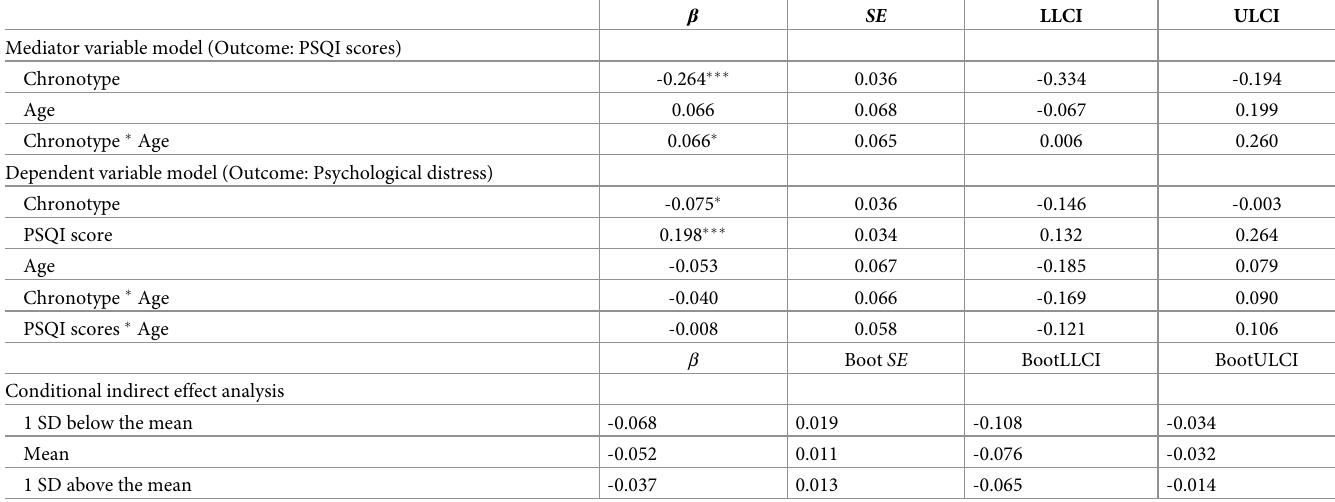
Table 4. Conditional process analysis (n =